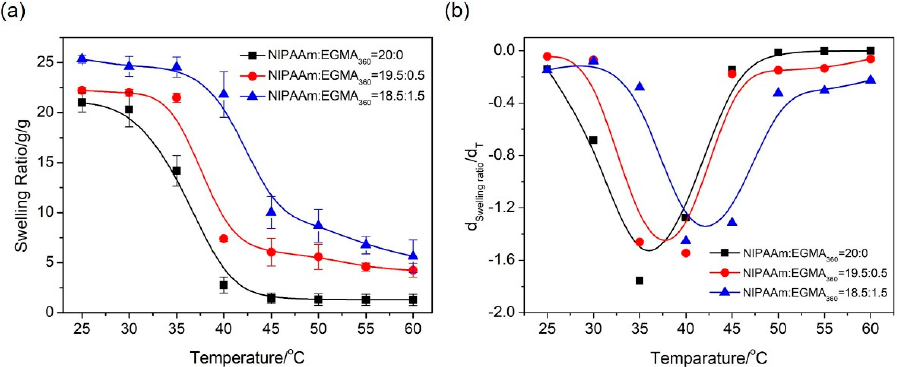
Figure 6. ( a ) Equilibrium swelling ratio of alginate-Ca 2+ /P(NIPAAm- co -EGMA 360 ) hydrogel as a function of temperature in water. ( b ) First derivatives of the equilibrium swelling ratios with respect to the temperature plotted as a function of temperature. The monomer ratios of NIPAAm to EGMA 360 are 20:0, 19.5:0.5, and 18.5:1.5.